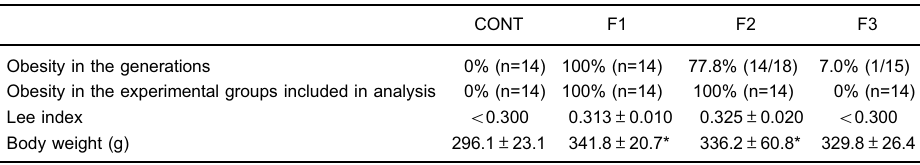
Table 1. Frequency of obesity, Lee index, and body weight of Control (CONT), monosodium glutamate- induced obese rats (F1), obese offspring (F2), and grand offspring (F3)